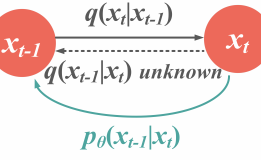
Figure 2. Illustration of transfer distributions between two diffusion steps. With the unsolvable q ( x t − 1 | x t ) , we approximate this reverse distribution with a parameterized model p θ